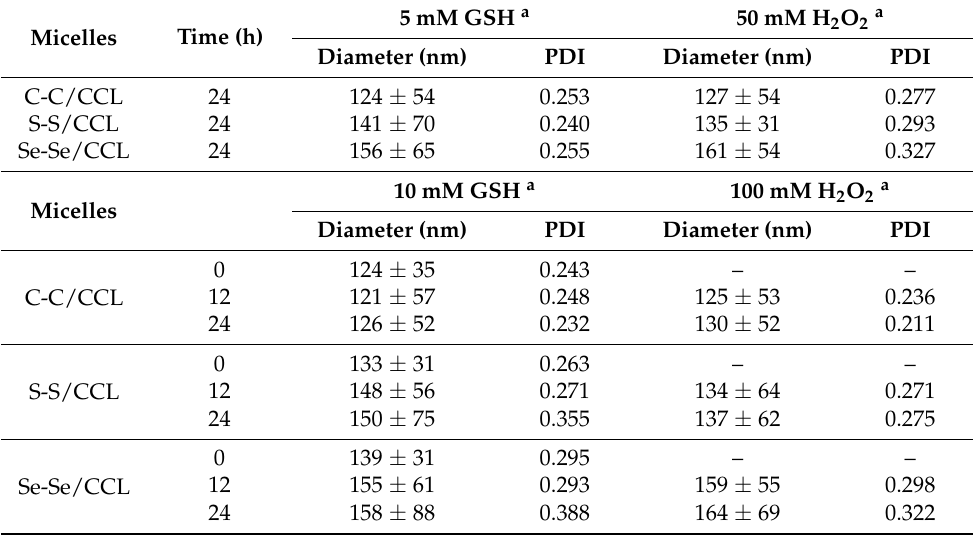
Table 3. Redox-responsive behavior of C–C/S–S/Se–Se CCL micelles with GSH and H 2 O 2 .